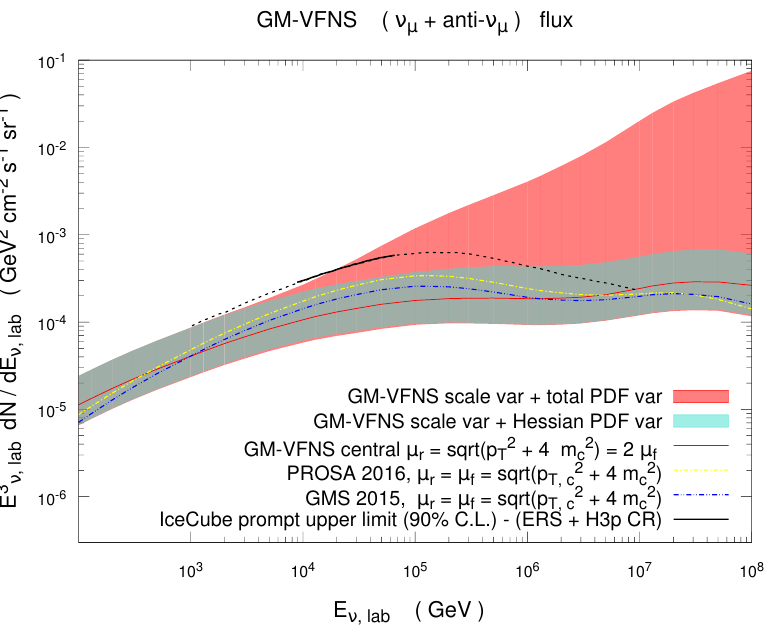
Figure 15 . Comparison of the prompt-( (cid:23) (cid:22) + (cid:22) (cid:23) (cid:22) ) (cid:13)ux from the GM-VFNS approach of this paper with the present upper limit on the prompt-neutrino (cid:13)ux at the 90% con(cid:12)dence level recently obtained by the IceCube experiment [1] (solid black line) and its extrapolation (dotted black line), which adopted the ERS model [75] as a basis for modeling prompt neutrinos. Central predictions using the scales (cid:22) r = (cid:22) f = p 2 + 4 m 2 with PROSA (PROSA 2016) and ABM11 PDFs (GMS 2015) c T are also shown. The limit and all predictions refer to the H3p CR p